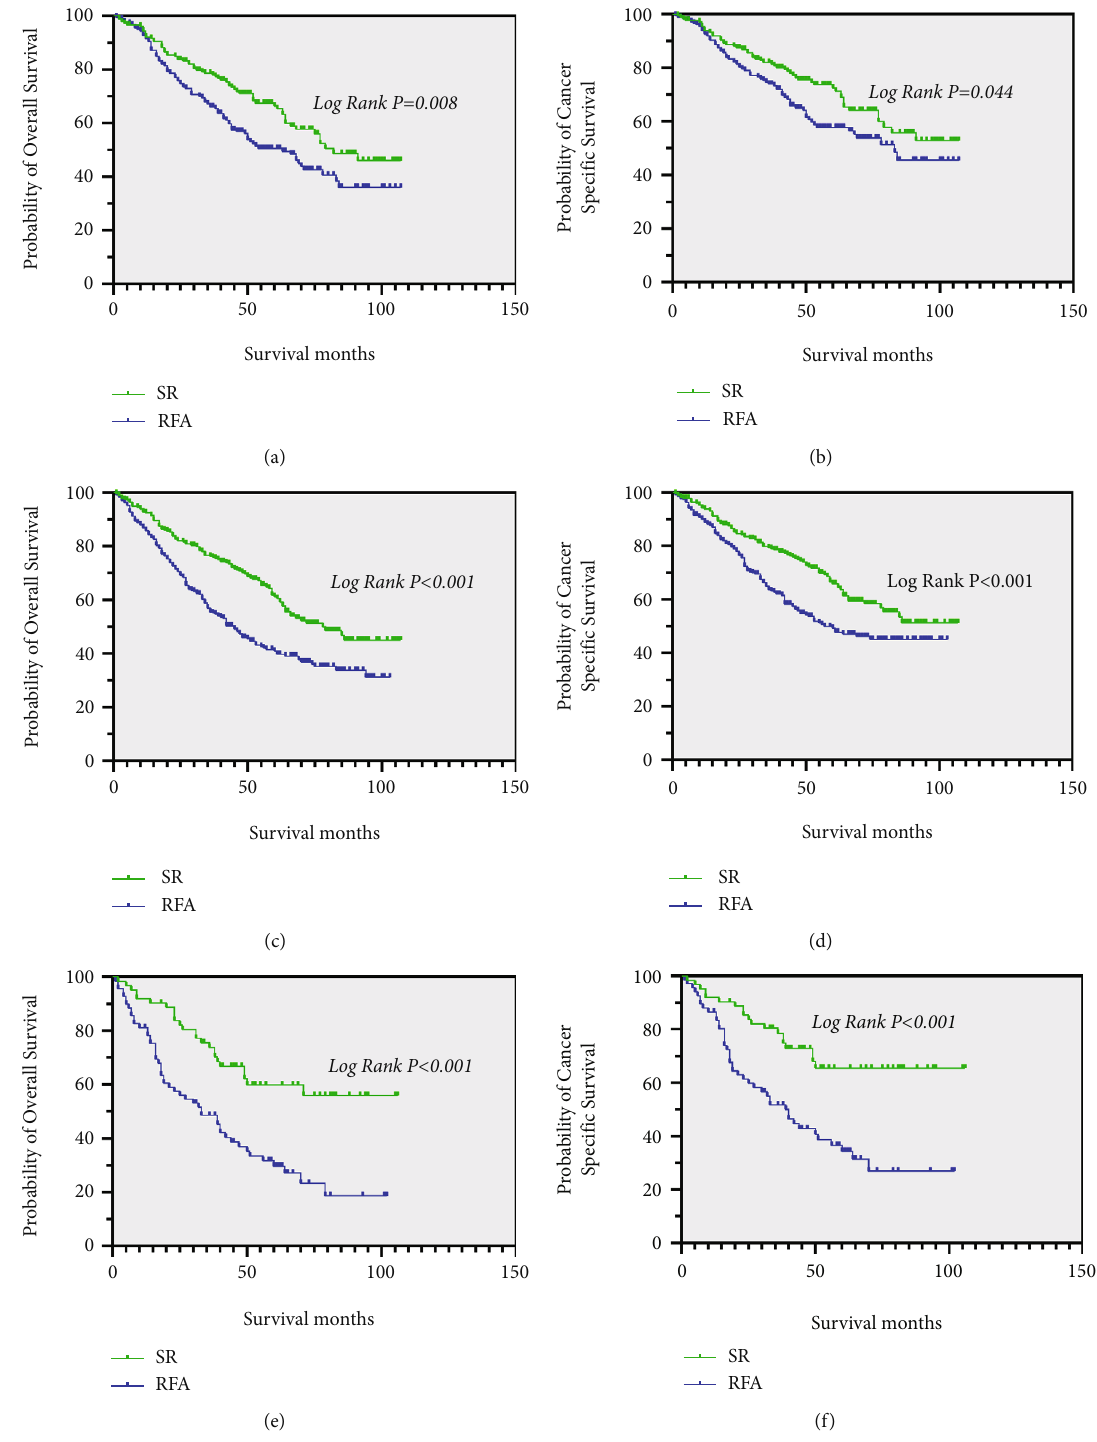
Figure 6: Kaplan – Meier curve of OS and CSS in patients with SR and RFA after PSM — (a and b) patients with Grade I tumors; (c and d) patients with Grade II tumors; (e, f) patients with Grade III and Grade IV